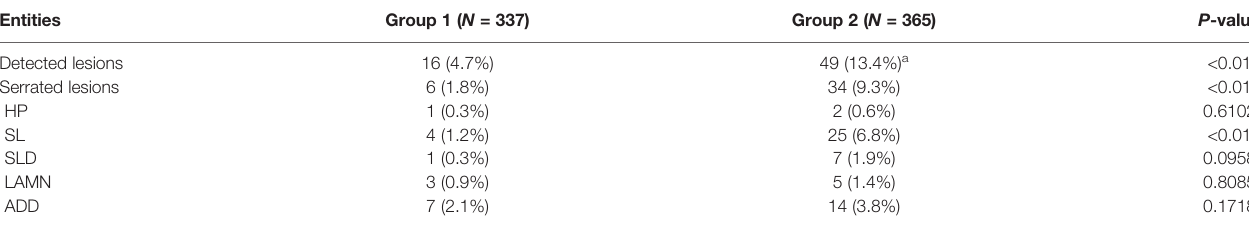
TABLE 3 | The incidence of appendiceal serrated lesions, LAMN, and ADD between different appendix submission groups. Entities Detected lesions